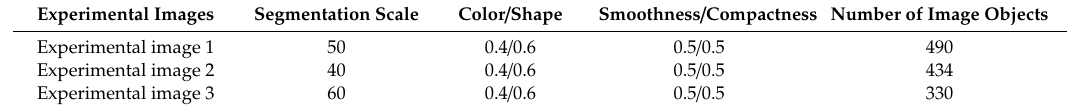
Table 2. Optimal image segmentation parameters.